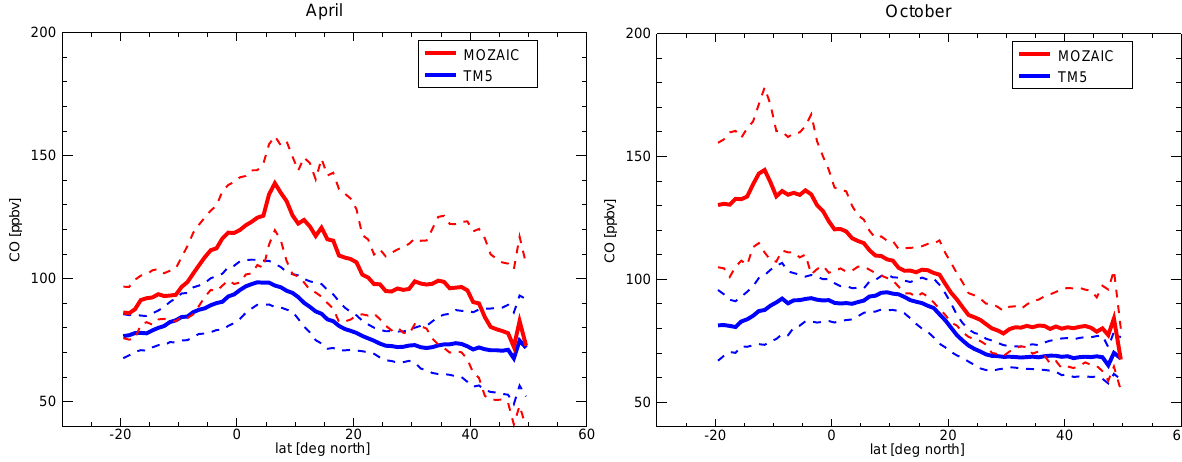
Fig. 6. Monthly mean comparisons of TM5 UTLS CO concentrations sampled at the measurement place and time against MOZAIC flight data between Frankfurt (50.0 ◦ N, 8.6 ◦ E) and Windhoek (17.7 ◦ E, 22.5 ◦ S) for April and October 2006. Dashed lines indicate the standard deviation in the monthly means. Data at pressures higher than 300hPa has been filtered out.